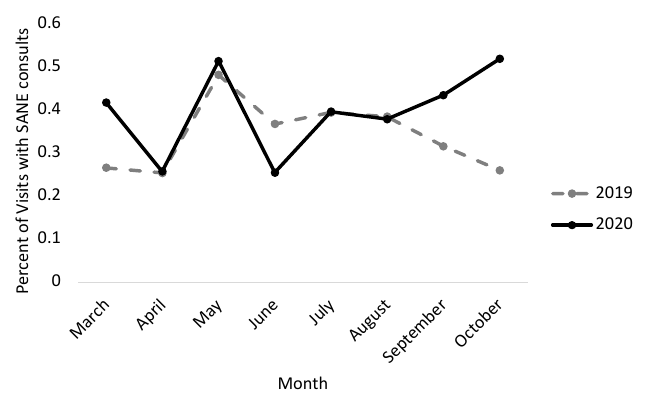
Figure 4. Percentage of emergency department visits with Sexual Assault Nurse Examiner consults from 2019-2020.